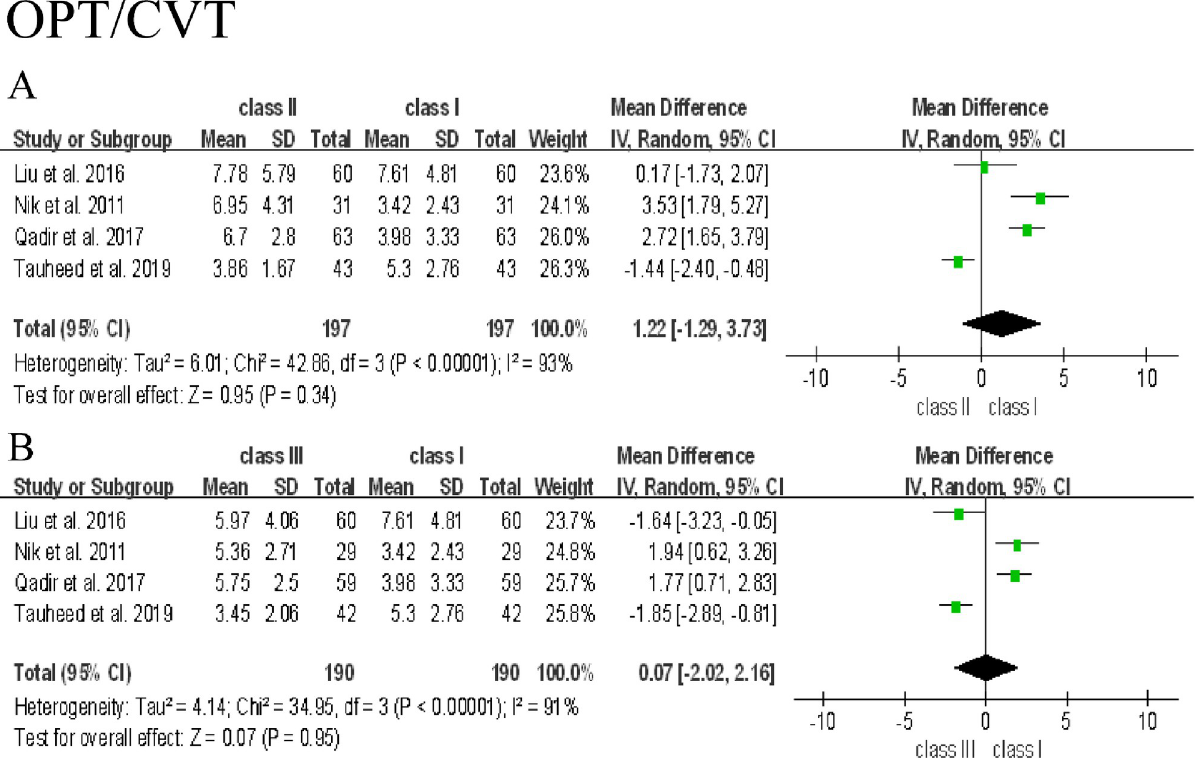
Fig 2. Forest plot of the association between cervical curvature and Class I, II, and III